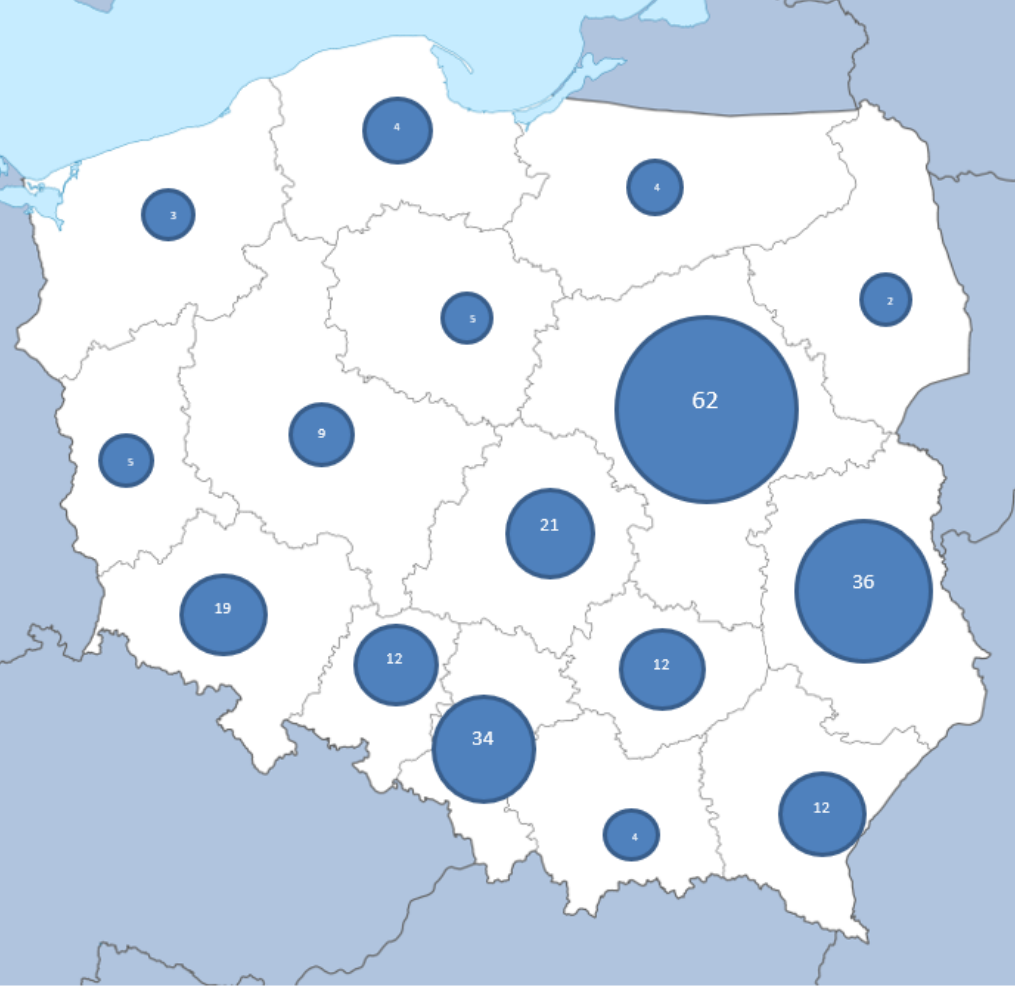
Source: This figure is adapted from the map available at https://commons.wikimedia.org/wiki/File:Poland_location_map_white.svg#file licenced under CC BY-Share Alike 3.0